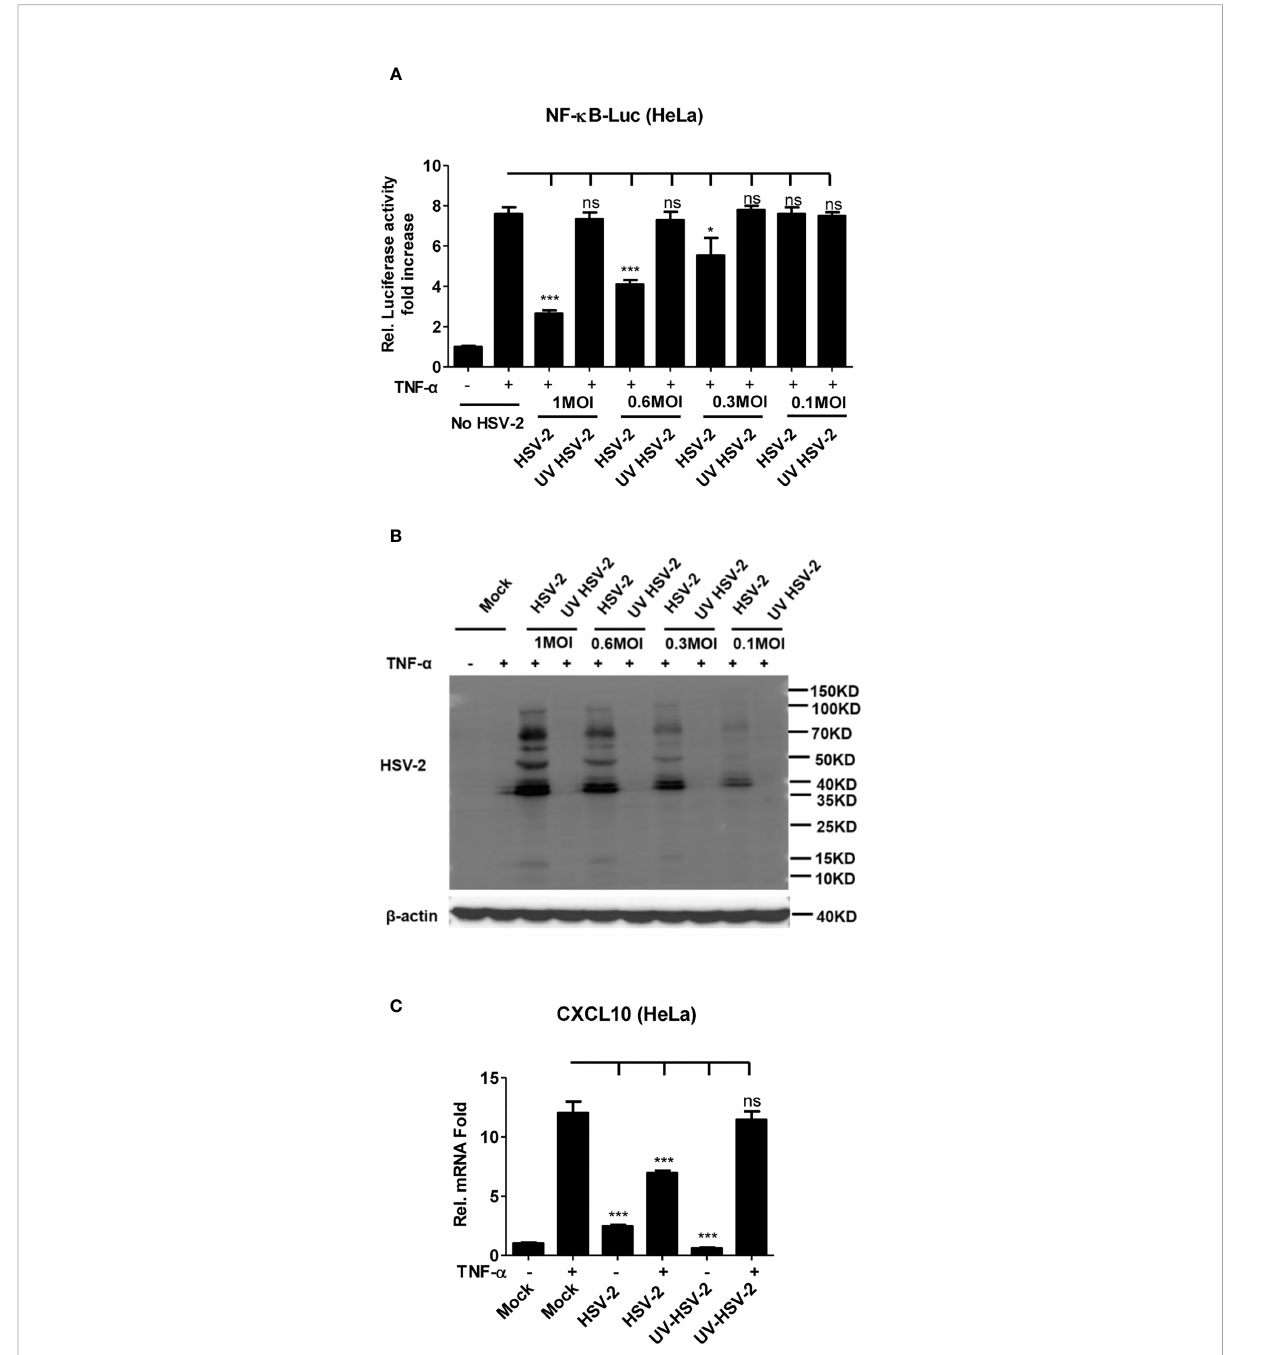
FIGURE 1 Productive HSV-2 infection suppresses TNF- a -induced NF- k B activation. (A) Productive HSV-2 infection suppresses TNF- a -induced NF- k B activation. HeLa cells were seeded in 24-well plates overnight and co-transfected with the reporter plasmids pNF- k B-Luc and phRL-TK. At 4 h post-transfection, cells were mock infected or infected with HSV-2 or UV-inactivated HSV-2 (UV HSV-2) at an MOI of 1, 0.6, 0.3, or 0.1. At 20 h post-infection, cells were stimulated with or without TNF- a (20 ng/ml) for 6 h. Reporter activities were determined by DLR assay. (B) Detection of viral protein expression in HSV-2-infected cells. HeLa cells were infected with HSV-2 or UV-inactivated HSV-2 at an MOI of 1, 0.6, 0.3, or 0.1 for 24 h. The expression of viral protein was detected by western blot using the anti-HSV-2 Ab. b -actin was used as a loading control. (C) HSV-2 infection inhibits CXCL10 mRNA production. HeLa cells seeded in 6-well plates were infected with HSV-2 or UV-inactivated HSV-2. At 24 h post- infection, cells were stimulated with TNF- a (20 ng/ml) for 6 h. Cells were harvested and total RNA was extracted. The expression of CXCL10 and GAPDH genes was evaluated by relative real-time quantitative PCR. For graphs, data shown are mean ± SD of three independent experiments with each condition performed in triplicate. For images, one representative experiment out of three is shown. *p < 0.05, ***p < 0.001. ns, not signi fi cantly. Rel,